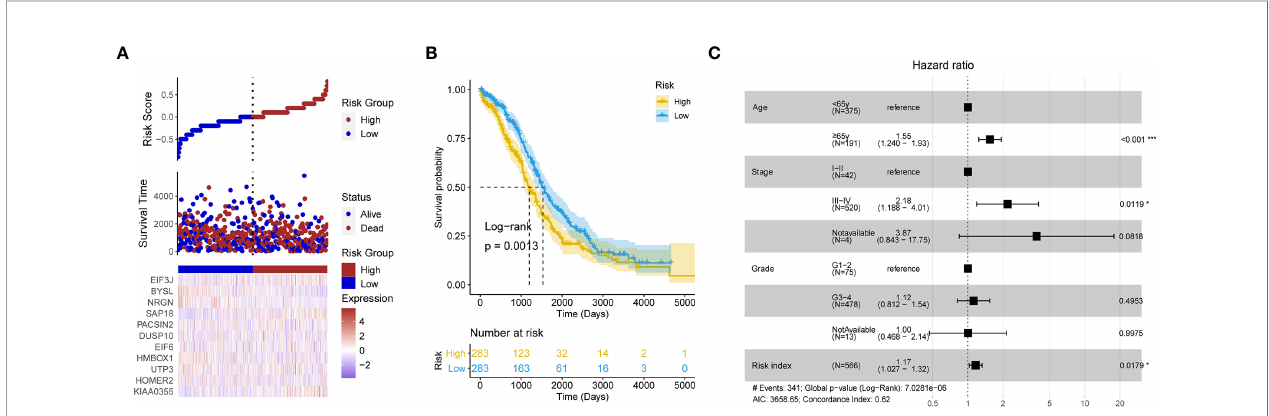
FIGURE 3 | The liquid-liquid phase separation-related gene signature was validated in the test set. (A) The risk plot of test set based the 11 liquid-liquid phase separation-related gene signature. (B) The patients with high risk index had signi fi cantly shorter overall survival than those with low risk index in the test set. (C) The risk index remains signi fi cant compared routine clinical features.